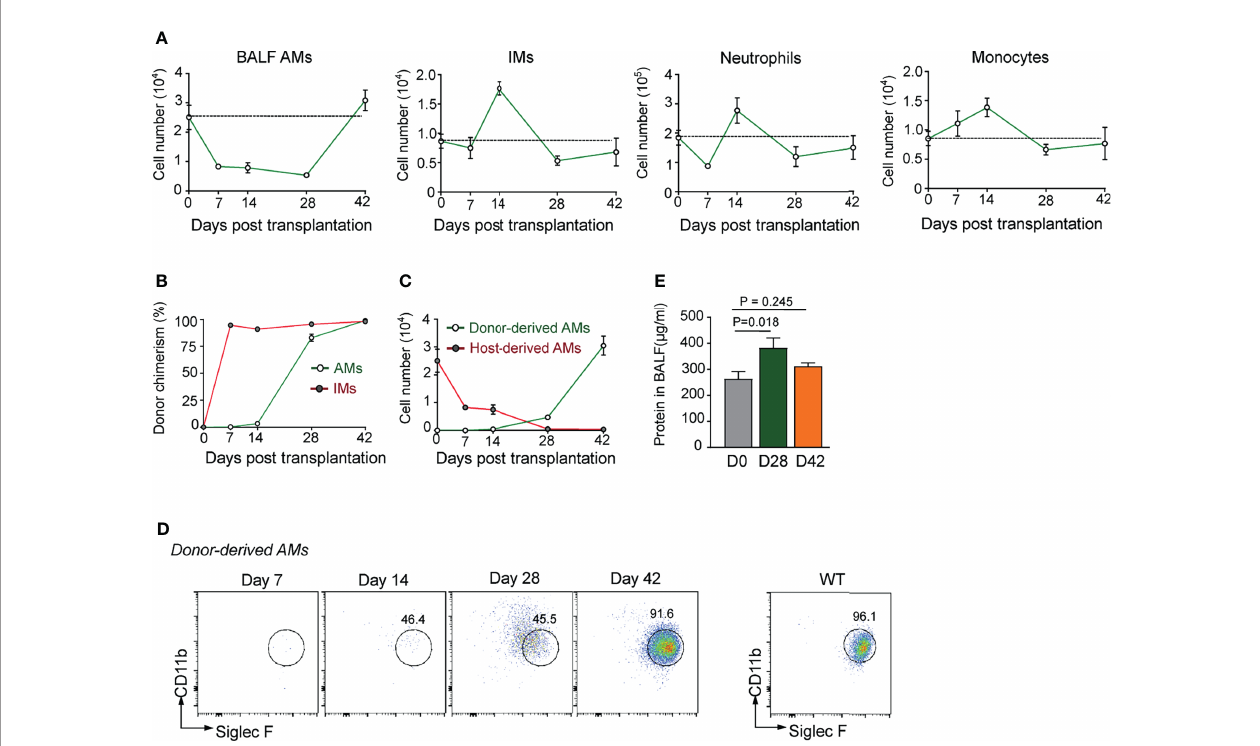
FIGURE 1 | Defective reconstitution of AMs in allogeneic recipient mice after TCD-BMT. (A) The number of BAL AMs, lung tissue IMs, neutrophils, and monocytes was analyzed at different time points after BMT of allogeneic recipient mice. Data shown are the pooled results of two independent experiments with three mice per group in each experiment. (B) Donor chimerism of lung AMs and IMs in allogeneic recipient mice was analyzed by fl ow cytometry according to the cell surface expression of H-2D b (donor) and H-2D b/d (host). (C) The numbers of host-derived AMs and donor-derived AMs in allogeneic recipient mice were analyzed by fl ow cytometry. (D) The cell surface expression of CD11b and Siglec F was analyzed on donor-derived AMs at different time points in allogeneic recipient mice. AMs were fi rstly gated by expression of CD11c and F4/80. (E) Allogeneic recipient mice were sacri fi ced, and total protein concentrations in BAL fl uid was measured by BCA Protein Assay kit. Total protein concentration in BAL fl uid of WT mice was shown as control. Data shown are the pooled results of three independent experiments with three to four mice per group in each experiment. Data are represented as mean ± SEM. AM, alveolar macrophage; TCD, T cell-depleted; BMT, bone marrow transplantation; BAL, bronchoalveolar lavage; IM, interstitial macrophage; WT, wild